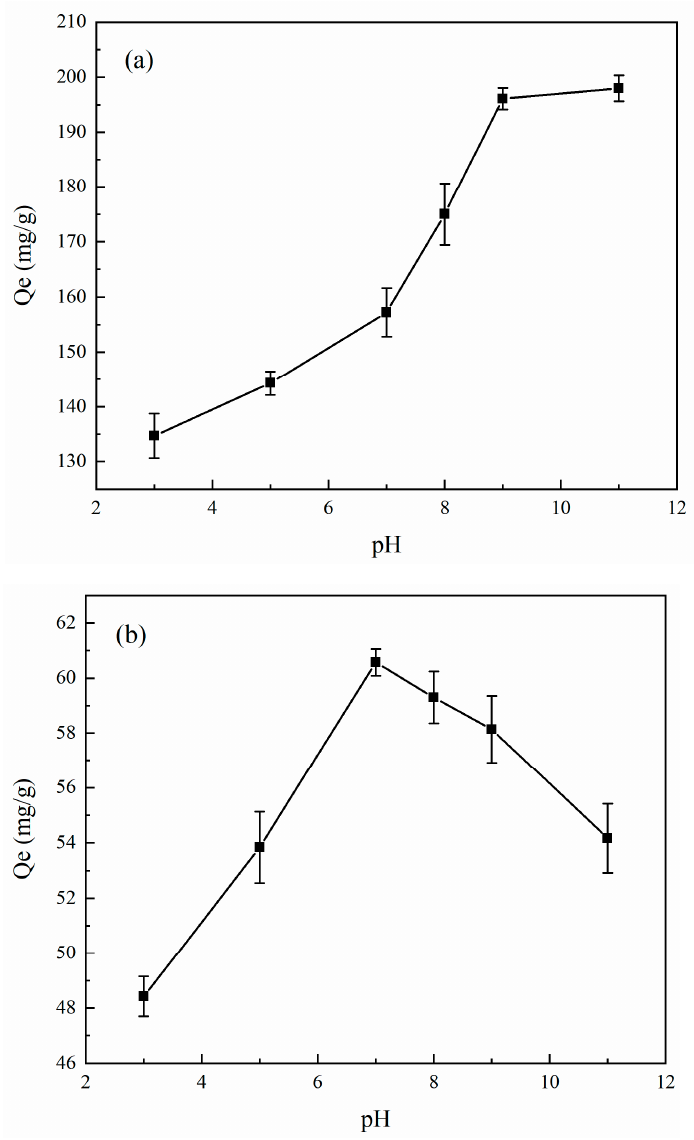
Figure 6. SAC adsorption of ( a ) MB and ( b ) OFL as a function of pH. It can be seen that the adsorption of MB is more effective in an alkaline environment and OFL is more effective in a neutral environment, and the adsorption of OFL is affected by either a strong acid or strong alkaline environment. The reason for this phenomenon may be that activated carbon shows a negative charge on its activated carbon surface in a solution with pH 11, which can react with the cationic basic dye methylene blue via electrostatic adsorption, contributing to a significant increase in the adsorption of activated carbon, while OFL hydrolysis molecules are present in three forms in an aqueous solution. When the pH value is acidic, the ofloxacin hydrolysis molecule is mainly present in the form of cations, and when the pH value is basic, the ofloxacin hydrolysis molecule is mainly present in the form of anions. At pH values between 6 and 8, most of the amphoteric ions in the solution have different pH values. When pH > 1, the surface of activated carbon is negatively charged. The ofloxacin hydrolysis molecule is present in the form of cations, and both are present in the form of cations and electrostatic attraction between the two occurs, causing the removal rate to continuously increase. When the pH is greater than 7, the activated carbon surface and the ofloxacin hydrolysis molecules have the same charge, and they are electrostatically repelled, so the removal rate and the equilibrium